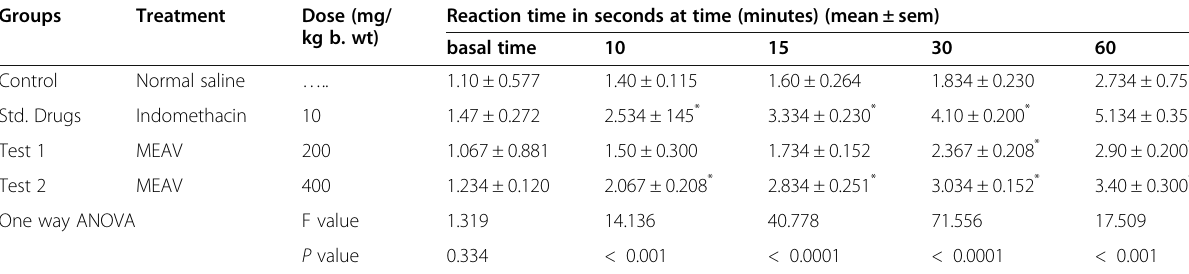
Table 5 Protective effect of methanol extract of A. vulgaris leaves extract on tail withdrawal reflexes induced by tail immersion method in mice Groups